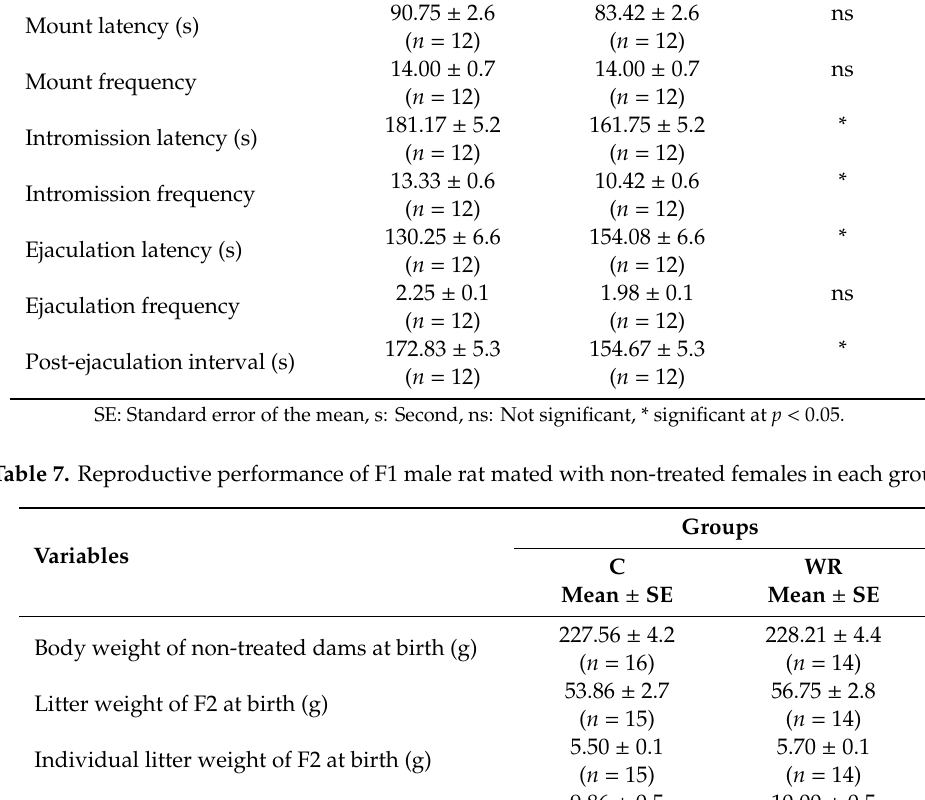
Table 6. Sexual behaviors of F1 male o ff spring of control or water-restricted groups. Variables